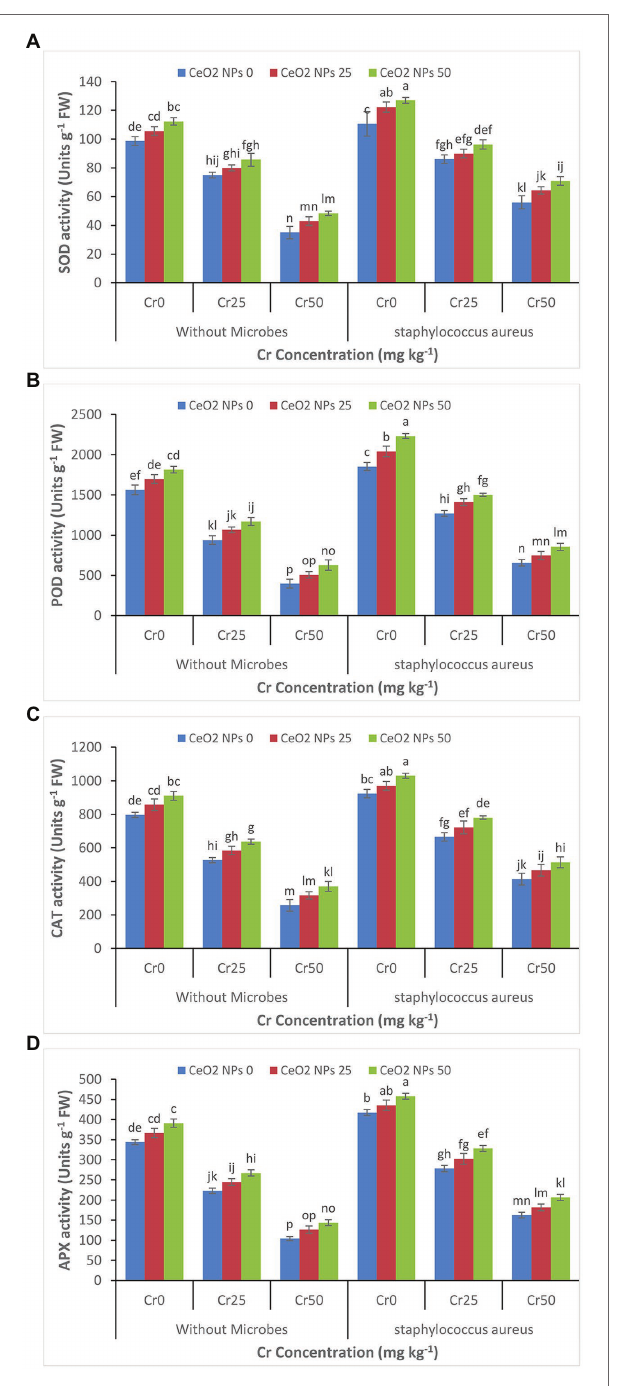
FIGURE 4 | (A–D) : Effect of CeO 2 NPs and Staphylococcus aureus on SOD activity (A) , peroxidases activity (B) , catalase activity (C) , and ascorbate oxidase activity (D) in sunflower plant under Cr stress. The given values are means of three replications with standard deviation. The alphabets represent the significant/non-significant difference at p ≤ 0.05.